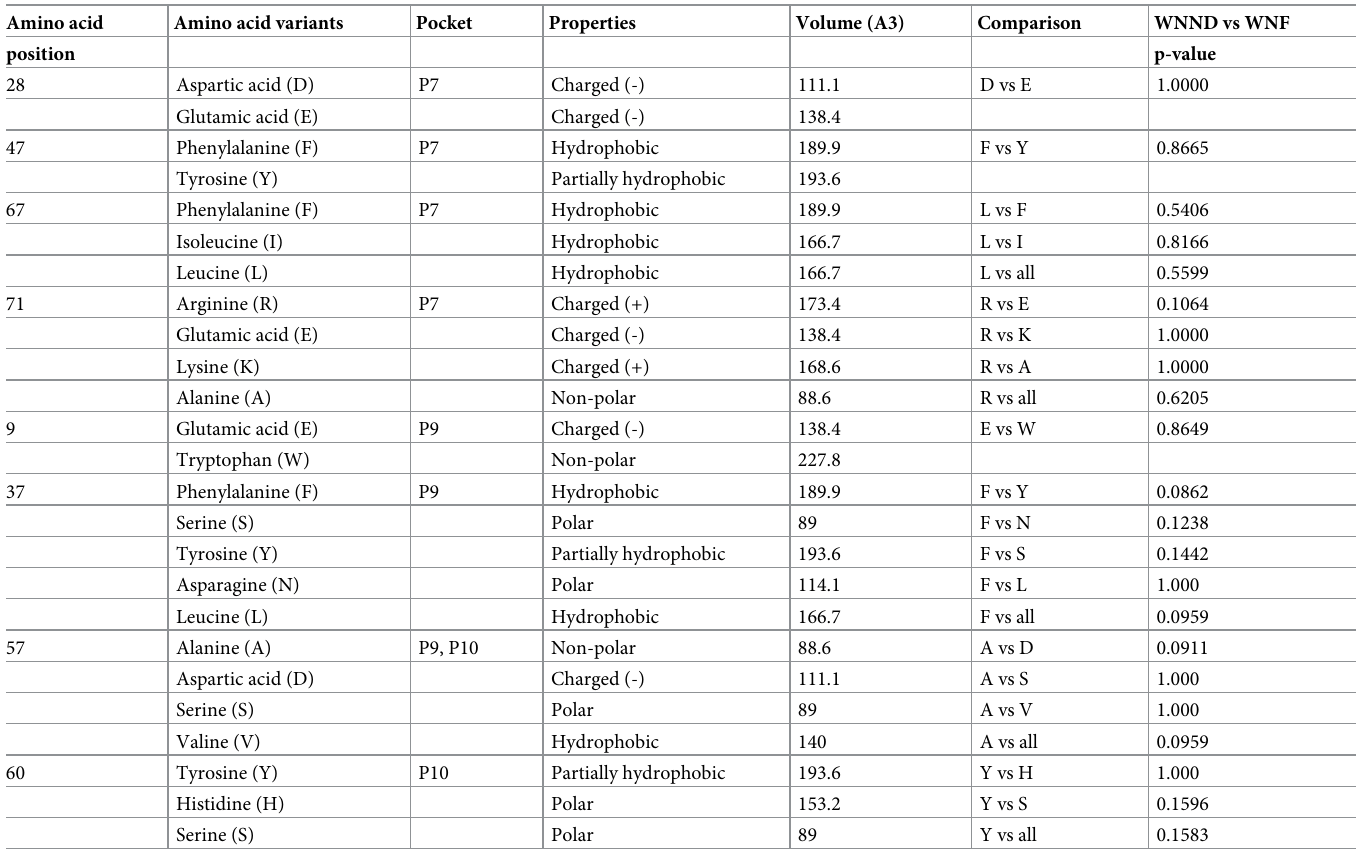
Table 4. List of WNV neuroinvasion-associated amino acid residues in HLA-DRB1 and their properties [25]. Amino acid Amino acid